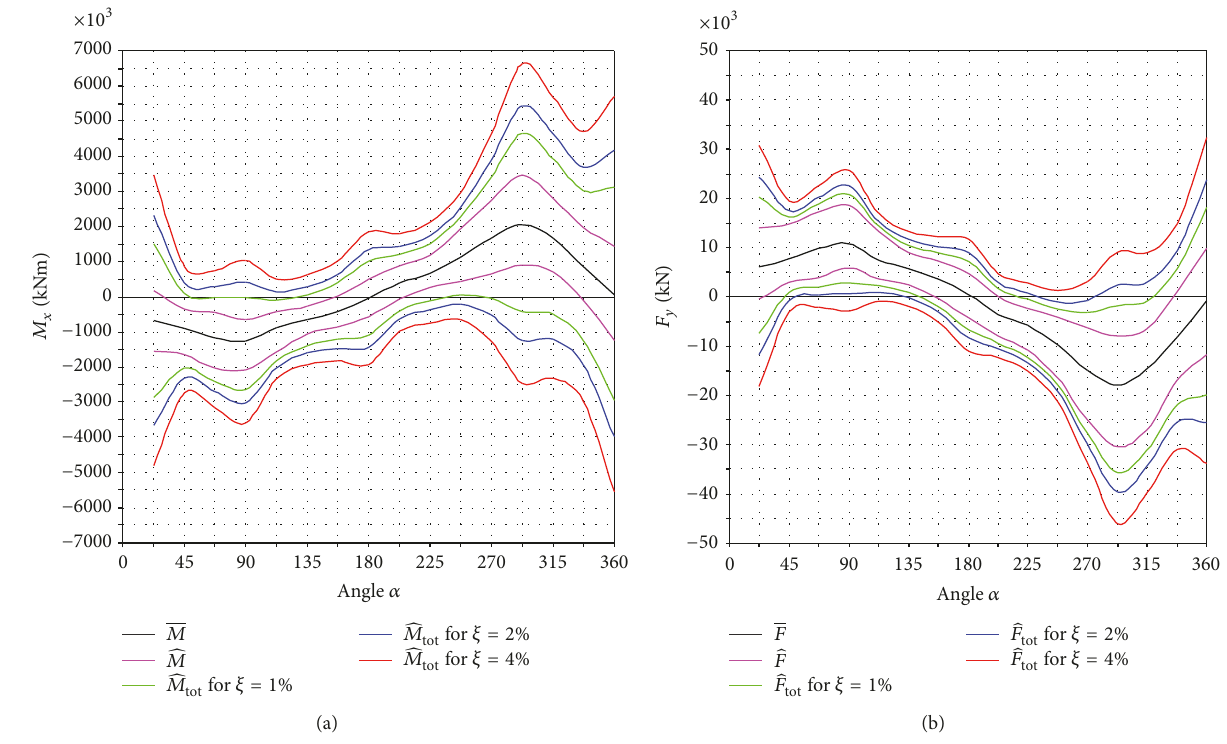
Figure 7: Base loads: (a) base moment in 𝑥 direction (𝑀 𝑥 ) and (b) base shear in 𝑦